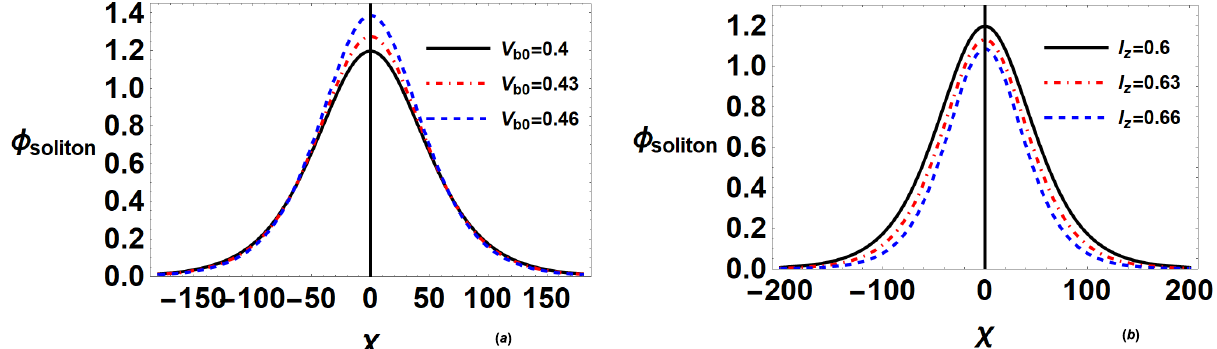
Figure 8. (Color online) Variation of solitary profile for different values of ( a ) beam velocity ( V b 0 ), ( b ) direction cosine ( l z ), with fixed values of µ b = 0.2, U 0 = 0.02, H = 0.2 and T =